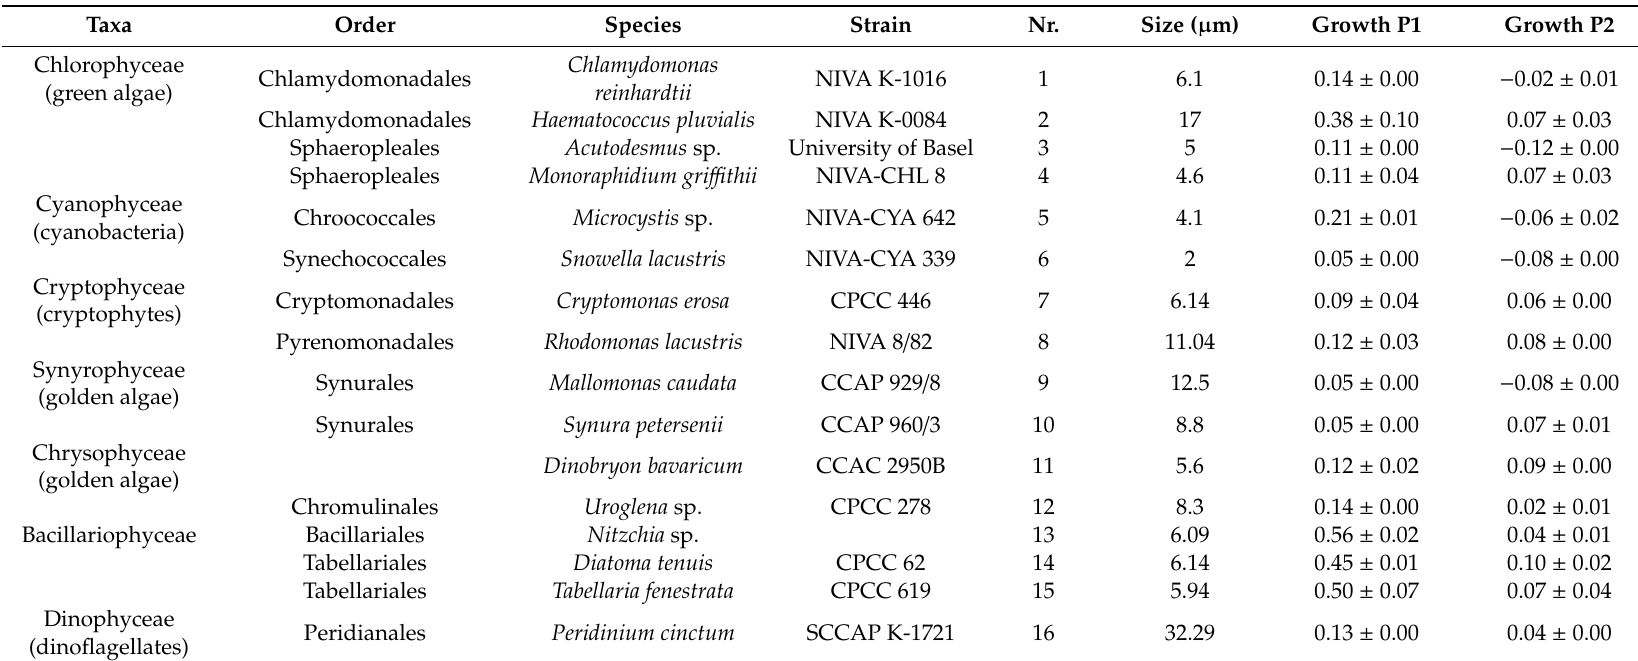
Table 1. Cultured phytoplankton strains (taxa, order, species, and strain number), their mean size (diameter by electronic cell counter, µ m), and growth phase rate (divisions d − 1 ) for the exponential phase (P1, sampling point 1) and stationary phase (P2, sampling point